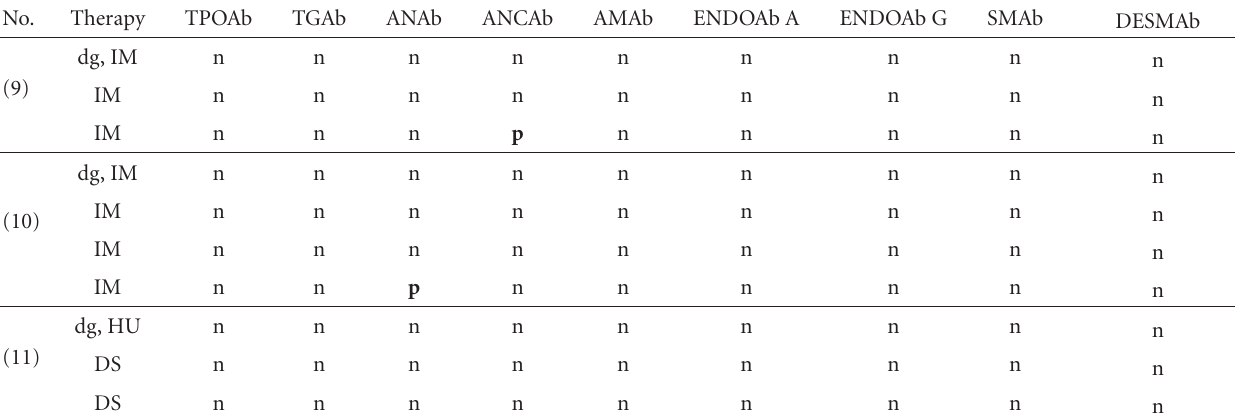
TPOAb: antibodies against thyroidal peroxidase; TGAb: antibodies against thyreoglobulin; ANAb: antinuclear antibodies; ANCAb: antibodies against the cytoplasm of neutrophils; AMAb: antimitochondrial antibodies; ENDOAb A, ENDOAb G: antibodies of the IgA and IgG classes against endomysium; SMAB: antibodies against smooth muscless; DESMAb: antidesmosomal antibodies. a Negative for the respective antibodies. b Positive for the respective antibody. c n.t.:not